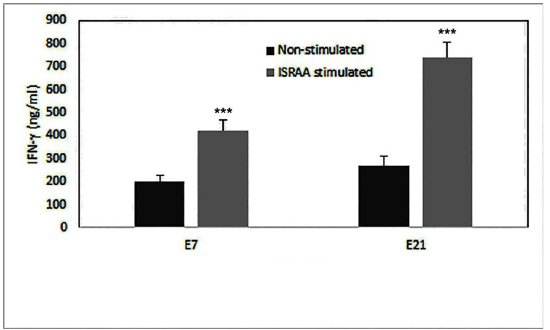
Fig 3. Spontaneous and ISRAA-induced IFN- γ production by embryonic astrocytes. Cell Released Capturing ELISA (CRC-ELISA) was used assess spontaneous and ISRAA-induced IFN- γ production by embryonic astrocytes. E7 and E21 astrocytes spontaneously produced this cytokine. Stimulation with recombinant ISRAA significantly increased IFN- γ production by E7 and E21 ( ��� p < 0.05). However. the induction of IFN- γ was significantly higher in E21 than in E7 astrocyte cultures ( ��� p < 0.05). Experiments were conducted twice with alike findings. Bars represent the means ± SDs of 12